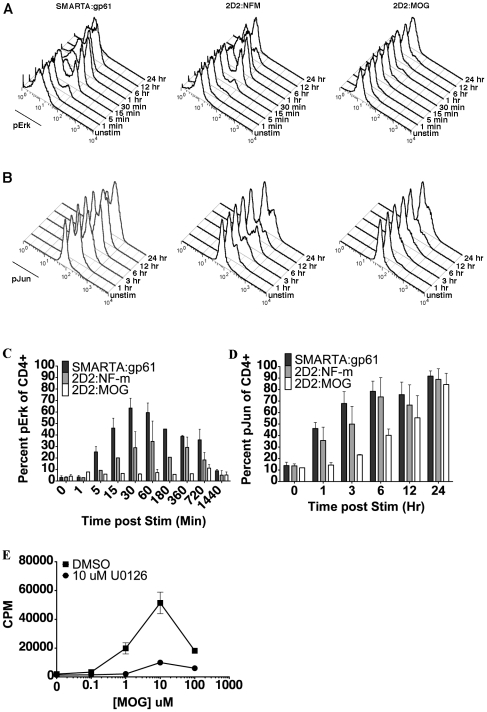
2D2 cells stimulated with MOG have no detectible pErk and delayed phosphorylation of c-Jun.Splenocytes from SMARTA or 2D2 mice were stimulated with 10 µM of the indicated antigen and signaling events were assessed. (A) A representative plot of pErk expression assessed at various time points by flow cytometry, gated on CD4+ cells. (B) A representative plot of p-c-Jun expression assessed at various time points by flow cytometry, gated on CD4+ cells. Graphical representation of averaged p-Erk (C) and p-c-Jun (D) expression are from at least three independent experiments at various time points. (E) Cell proliferation was assessed after treatment with the Erk-specific MEK inhibitor U0126. All experiments were repeated at least three times.